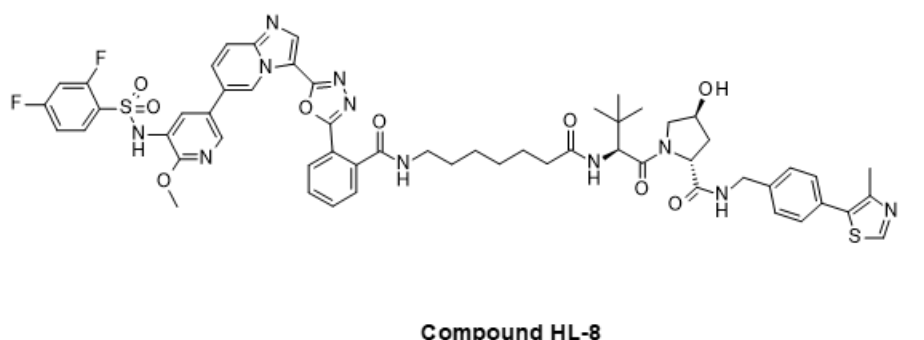
Figure 10. Compound HL-8: a recently reported PROTAC degrader of PI3K.